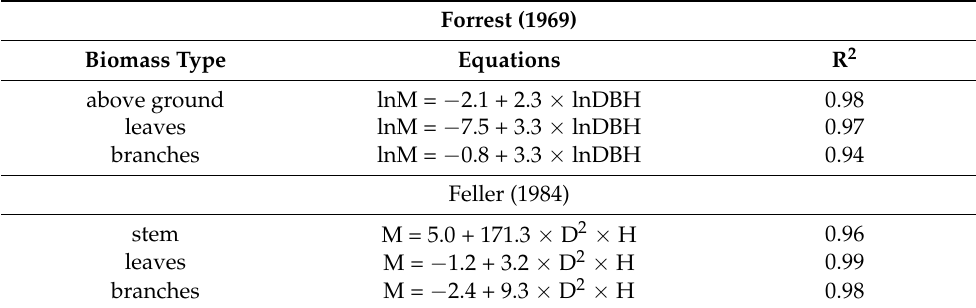
Table 2. Allometric equations employed and estimated total harvesting residue in the case study (Equations were developed by Forrest 1969 and Feller 1984).